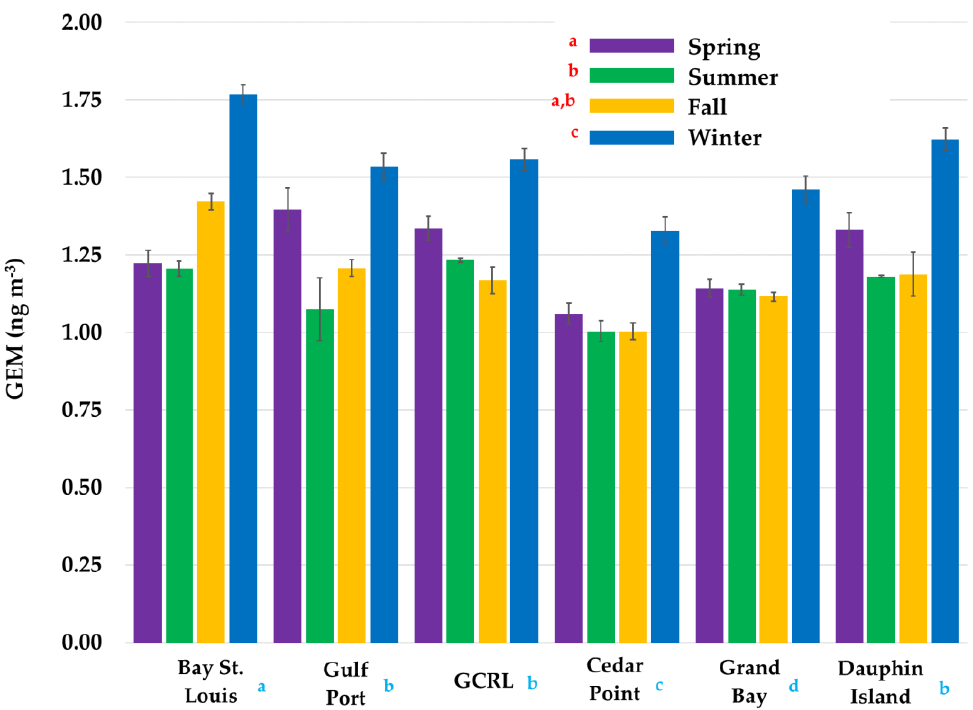
Figure 3. GEM concentrations determined using passive air samplers (PASs) deployed at six sites along the nGoM from May 2019 to February 2020. Sites are depicted west to east (from left to right) and error bars represent 1 standard error. Results for two sets of statistical analyses are shown: (1) pairwise means comparisons for the main effect of season (red letters), and (2) pairwise means comparisons for the main effect of location (blue letters). Seasons or locations that do not share letters are statistically different ( p < 0.05) as determined by Tukey’s honest significant difference tests. The season ∙ location interaction is described in the text.